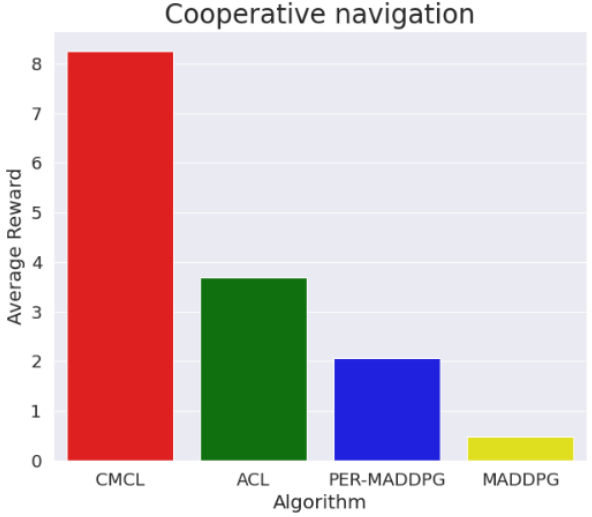
Landmark Figure 10. Diagram of the training effect of CMCL algorithm in cooperative environment. 5.1.2. Competition Experiment In a cooperative training environment, agents share the observed value of the envi- ronment to maximize the total reward value, but in a multi-agent competition task, as training progresses, the policies of their opponents are constantly improved, resulting in the continuous fluctuation of the cumulative reward value. In addition to cooperating with other agents, the agent also needs to make policy corrections for the opponent’s pol- icy. The multi-agent competition experiment uses the predator-prey experiment in the MPE environment. On a two-dimensional plane with side length 1, 𝑚 predators and 𝑛 prey are randomly generated, as well as three randomly generated obstacles, whose area is relatively large, which can prevent the intelligent body from observing and moving. The goal of predators is to capture prey as quickly as possible through team cooperation. During this process, the predators and the prey move randomly, and the prey move twice as fast as the predators. During the predation process, all predators form a team to hunt down the prey, and the capture is considered successful when the distance between the predator and the prey is less than the pursuit radius. To construct the sparse reward scene of the predator-prey environment, the dense reward function set according to the distance between predator and prey is canceled. Therefore, the reward value obtained by the predator agent at each time step consists of two parts: 1. When the predator encounters the prey, it will receive a positive reward value, that is, the capture reward value 𝐷 1 ; 2. To prevent agents from escaping the bound- ary, when agent hits the wall, it will receive a negative reward value, that is, the collision reward value 𝐷 2 . The capture reward is as follows: